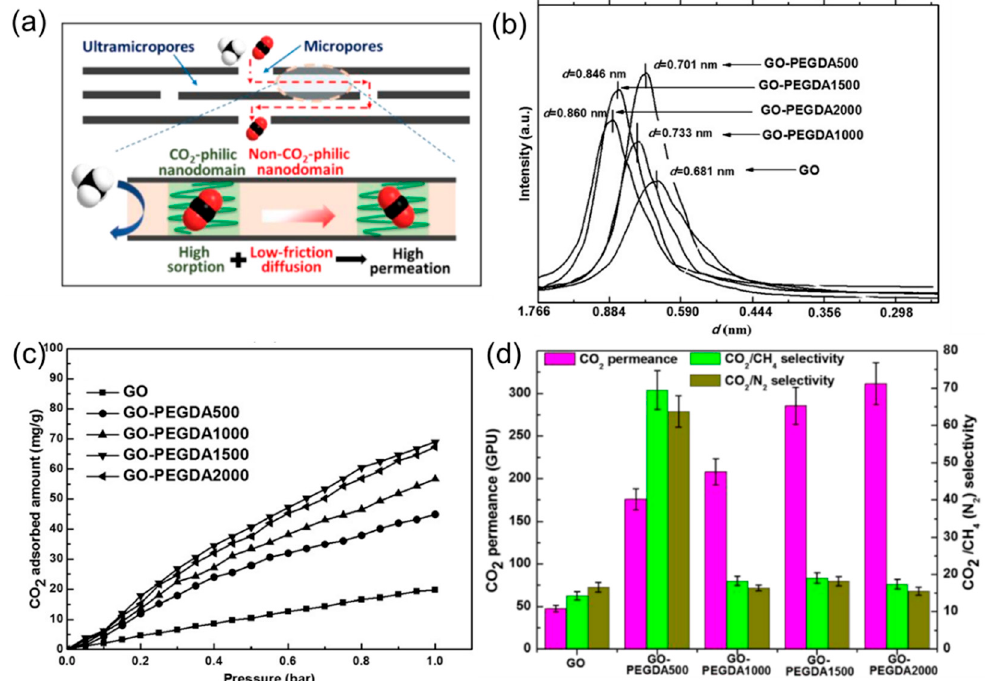
Figure 8. ( a ) Schematic of gas transport in GO membrane channels composed of both CO 2 -philic and non-CO 2 -philic nanodomains. ( b ) XRD patterns of GO and GO-PEGDA samples with the corresponding d-spacings. ( c ) CO 2 sorption isotherms of the membranes. ( d ) Mixed-gas separation performances of the membranes tested in the dry state at 2 bar and 30 °C (50/50 vol% CO 2 /N 2 or CO 2 /CH 4 ). Adapted with permission from [34]. John Wiley and Sons, Inc.